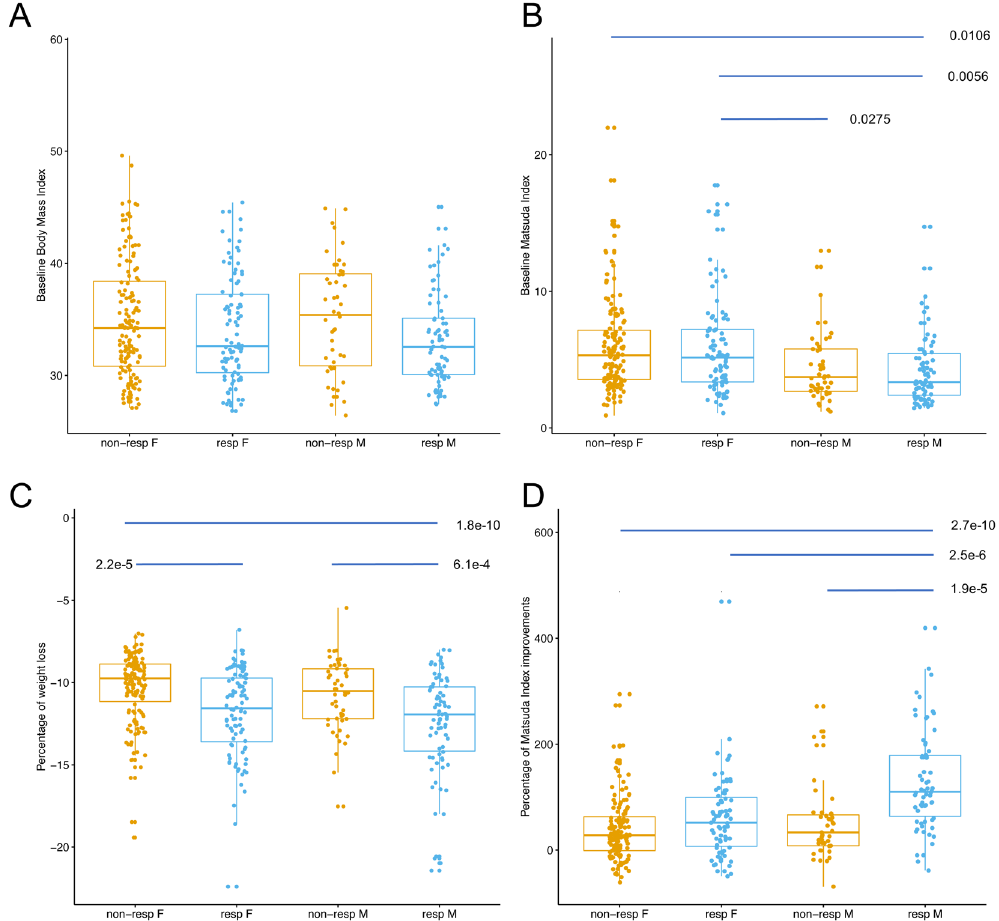
Figure 2. Boxplot of baseline BMI and Matsuda, and improvements during LCD. ( A ) Baseline BMI ( B ) baseline Matsuda index ( C ) percentage of BMI changes during LCD, relative to baseline ( D ) percentage of Matsuda index changes during LCD, relative to baseline. Groups are defined according to responder/non- responder status and gender (M/F). The displayed P-values were obtained from a Tukey Honest Significant Test (see Methods) and are adjusted for multiple testing. P-values greater than 5% are not